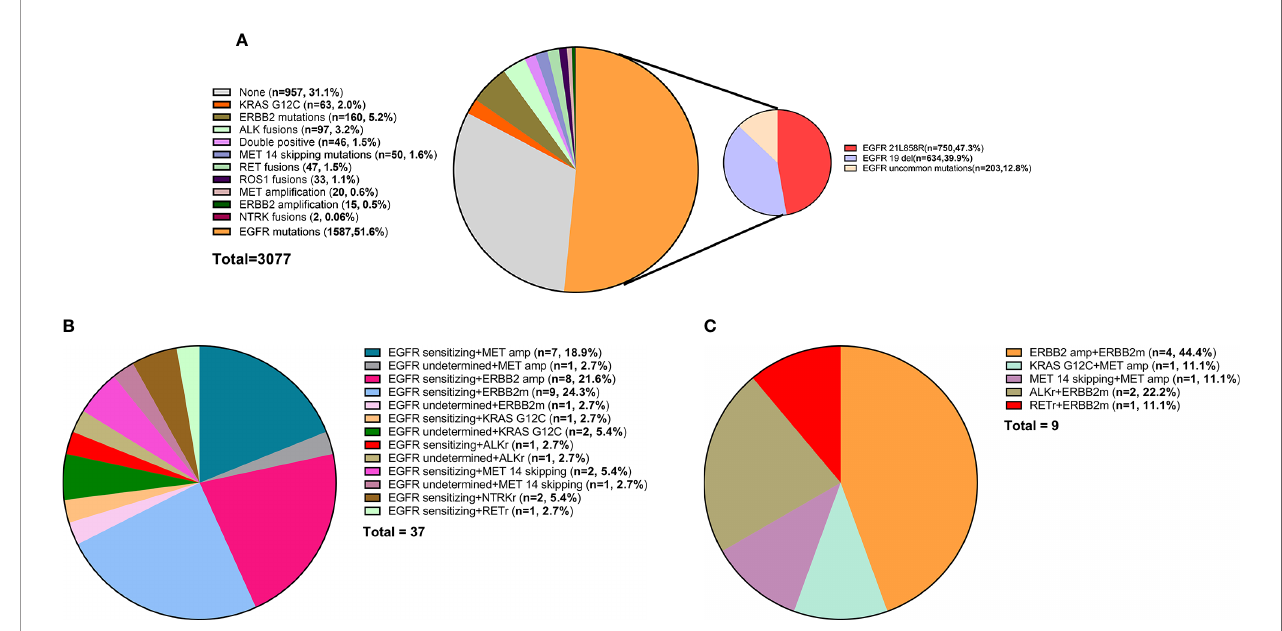
FIGURE 1 | (A) The frequency of different oncogenic drivers in all patients. (B) Composition of EGFR -mutant NSCLC patients harboring other potentially actionable oncogenic drivers. (C) Composition of NSCLC patients harboring co-occurring potentially actionable drivers without EGFR mutations. Composition of patients with lung adenocarcinoma from MKSCC harboring co-occurring potentially actionable oncogenic drivers. double-positive, with two potentially actionable oncogenic drivers; triple-positive, with three potentially actionable oncogenic drivers; del, deletions; EGFR sensitizing, sensitizing EGFR mutations, EGFR undetermined, undetermined EGFR mutations; amp, ampli fi cation; ERBB2 m, ERBB2 mutation; MET 14 skipping, MET exon 14 skipping mutation; ALK r, ALK rearrangement; NTRK r, NTRK rearrangement; RET r, RET rearrangement.